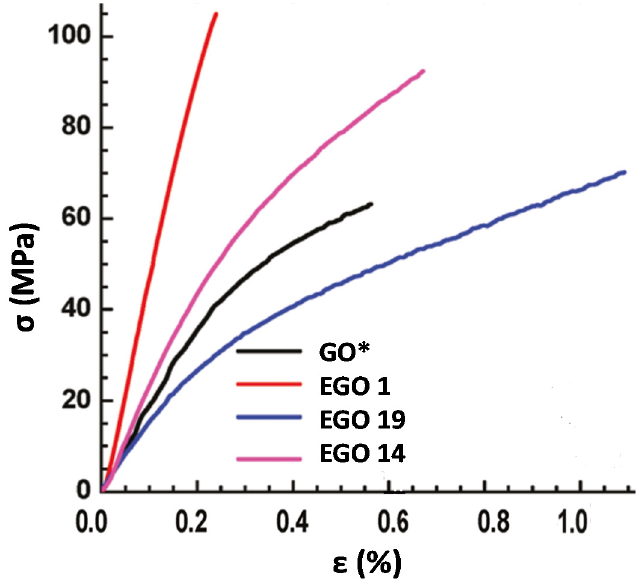
Figure 9. Typical stress–strain curves of the indicated samples.